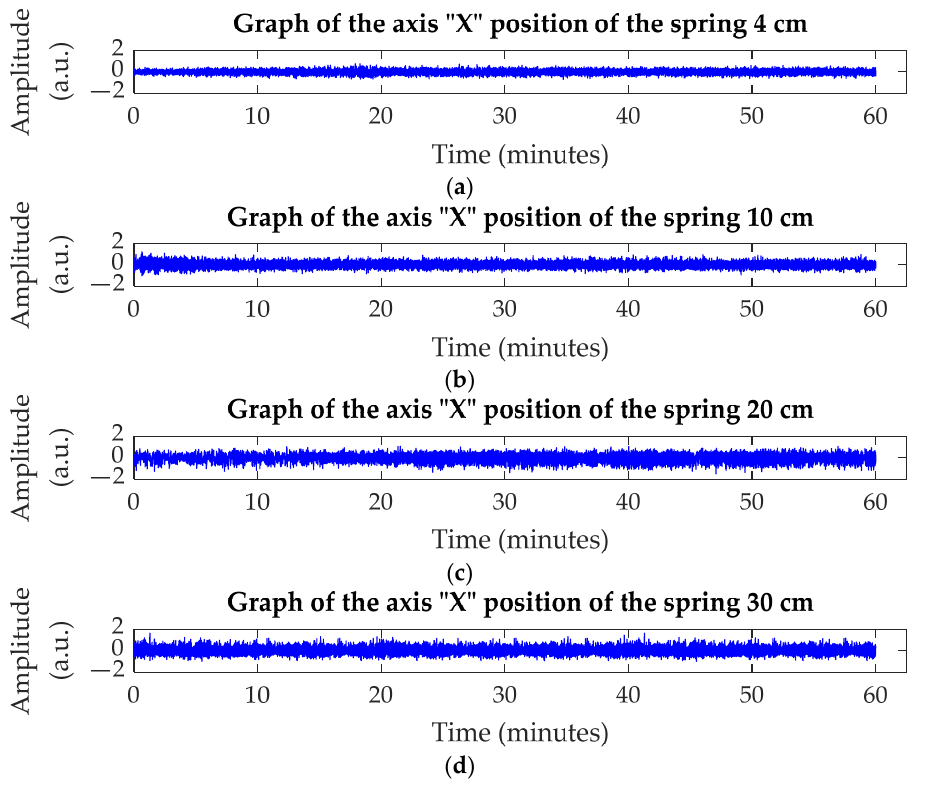
Figure 3. ( a ) ratio between amplitude of the “X” axis and time in seconds at spring position 4 cm, a.u. (arbitrary units); ( b ) ratio between amplitude of the “X” axis and time in seconds at spring position 10 cm, a.u. (arbitrary units); ( c ) ratio between amplitude of the “X” axis and time in seconds at spring position 20 cm, a.u. (arbitrary units); ( d ) ratio between amplitude of the “X” axis and time in seconds at spring position, a.u. (arbitrary units).